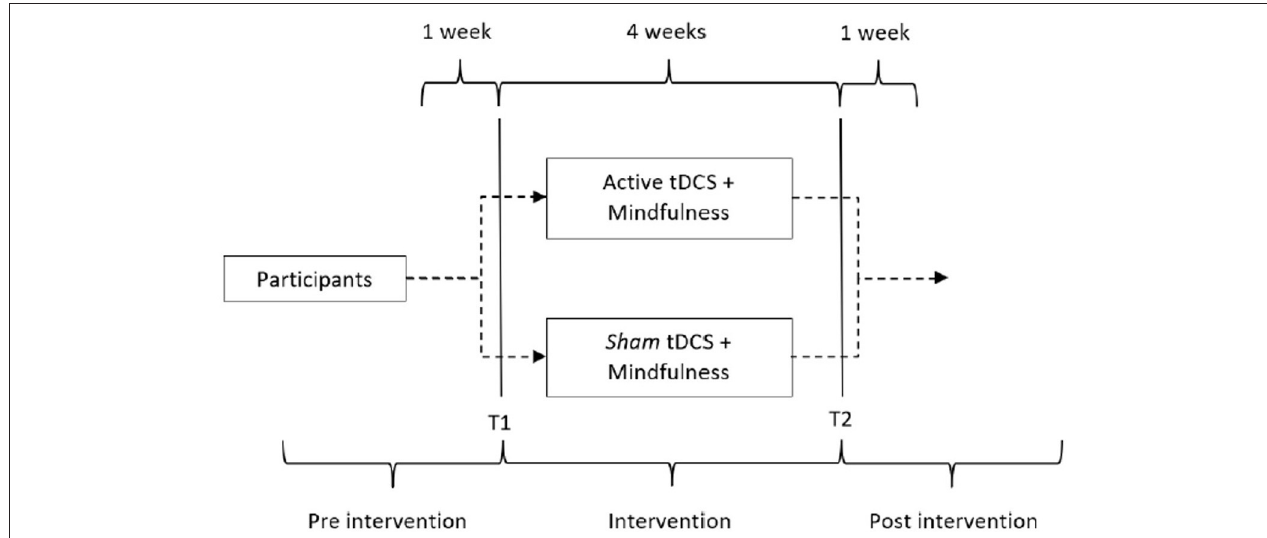
FIGURE 1 | Active tDCS study design vs. sham, both associated with mindfulness in chronic migraine. T1, baseline; T2, end of